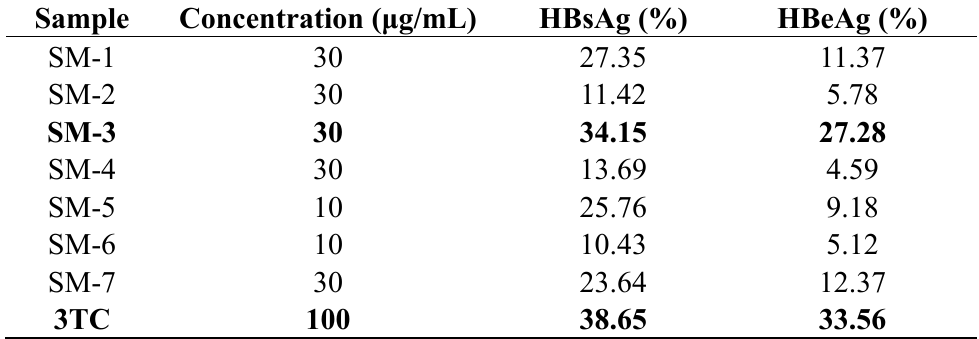
Table 1. Comparison of the anti-HBV activity demonstrated by different S. media components.